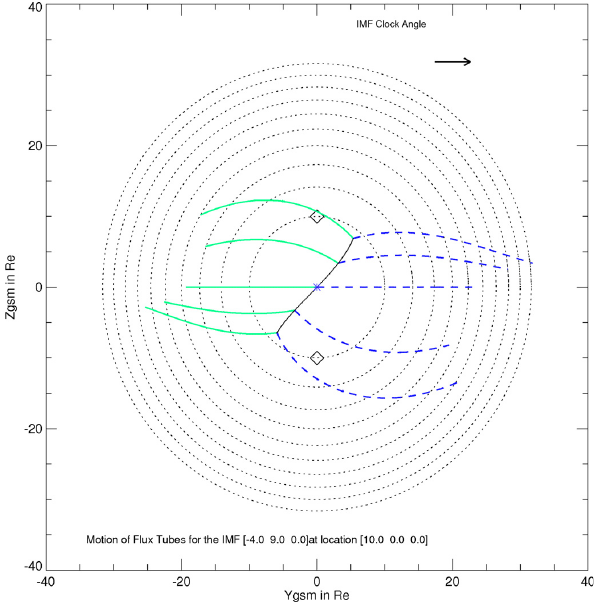
Fig. 10. Output of the Cooling model corresponding to the late observation of SC3 after 08:00UT when the IMF is dominated by B y . The blue dashed and green solid lines show the path of newly- reconnected field lines from the X-line (black solid